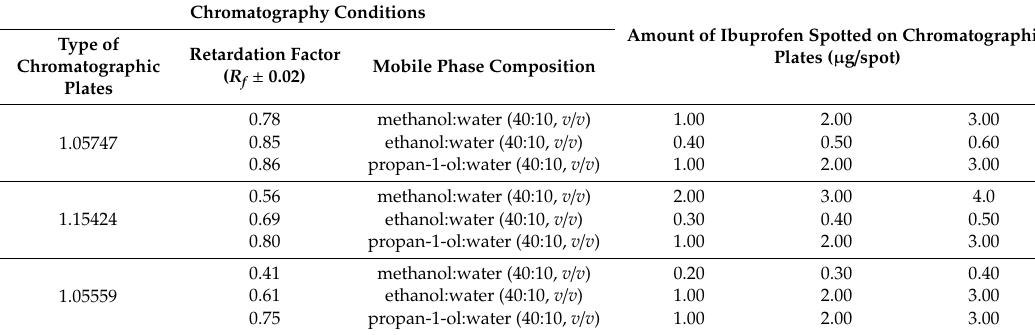
Table 1. Amount of ibuprofen used to prepare specific calibration curves (RP-TLC system). Chromatography